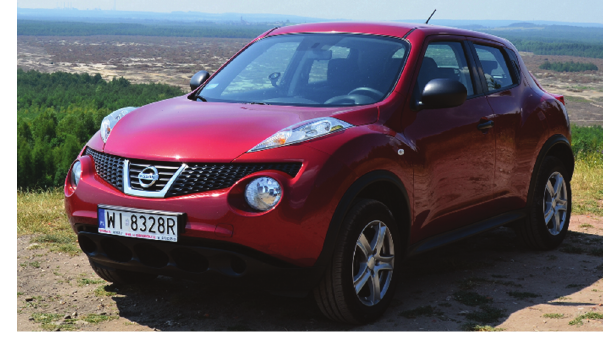
Fig. 1. Vehicle subject to road tests Table 1. Technical specifications of the vehicle tested